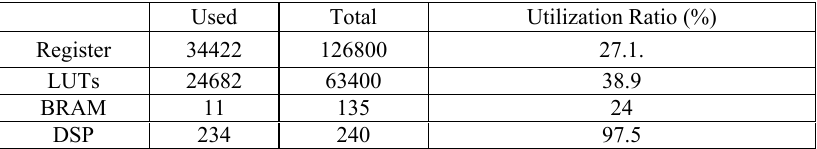
Table 1. Artix resource